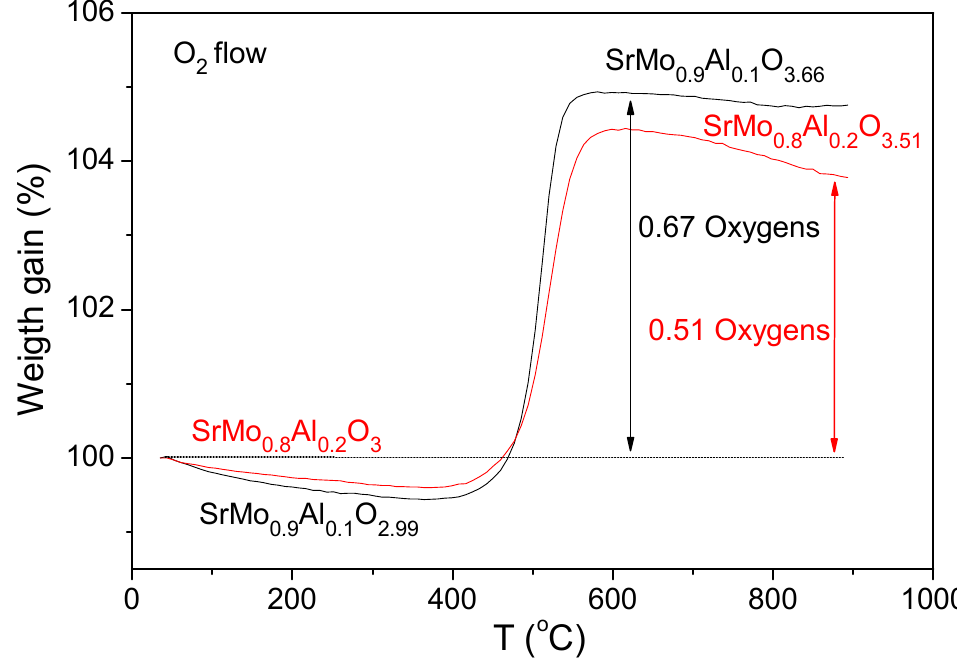
Figure 7. Thermal analysis curves for the SrMo 0.9 Al 0.1 O 2.99 and SrMo 0.8 Al 0.2 O 3 samples in O 2 flux. After the thermogravimetric analysis, an NPD study of SrMo 0.9 Al 0.1 O 3.66 was